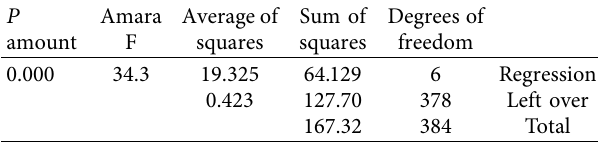
Table 6: Analysis of variance of research variables.